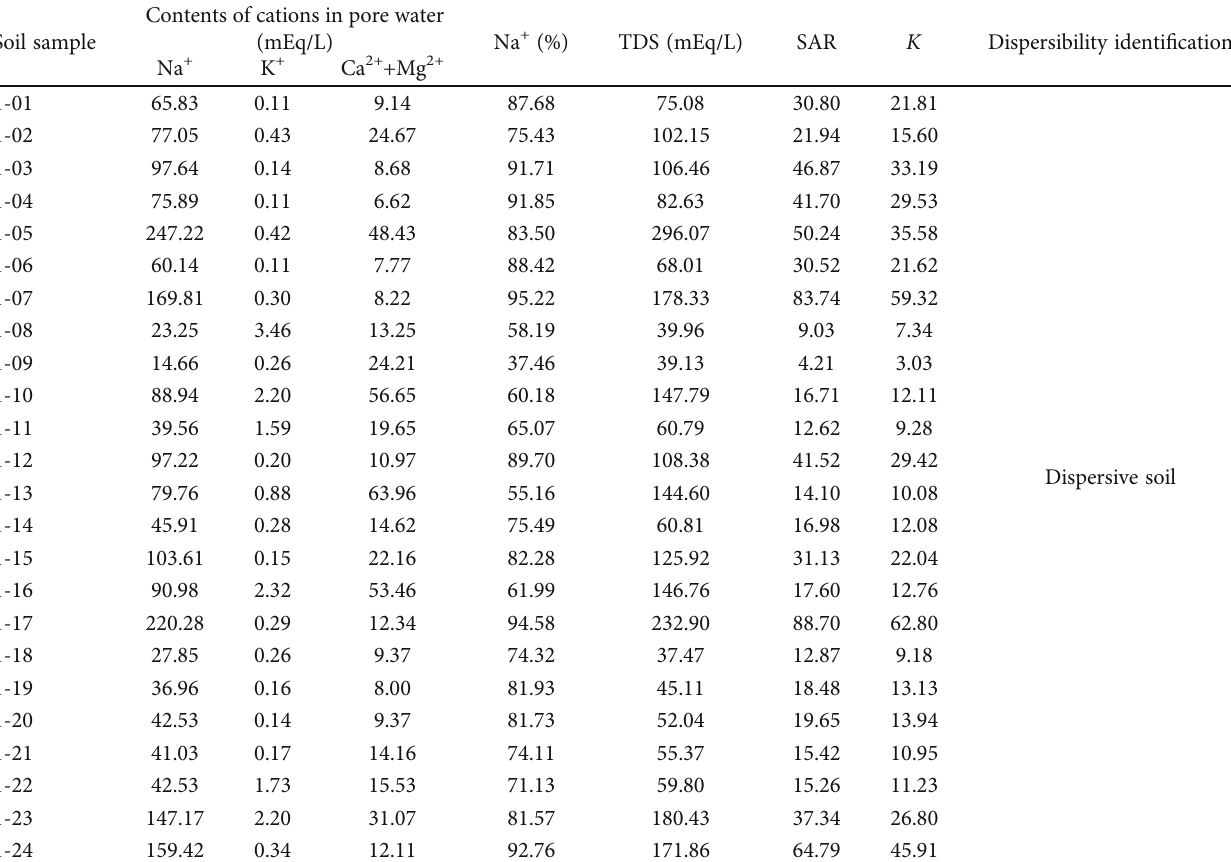
, C , and the soluble salt content [5, 32]. The total amount of soluble salt in TDS PS = M + M + M + M . The mole percentage of Na + is calculated as follows: C TDS Ca Mg Na K Table 5: Experimental results of SAR.